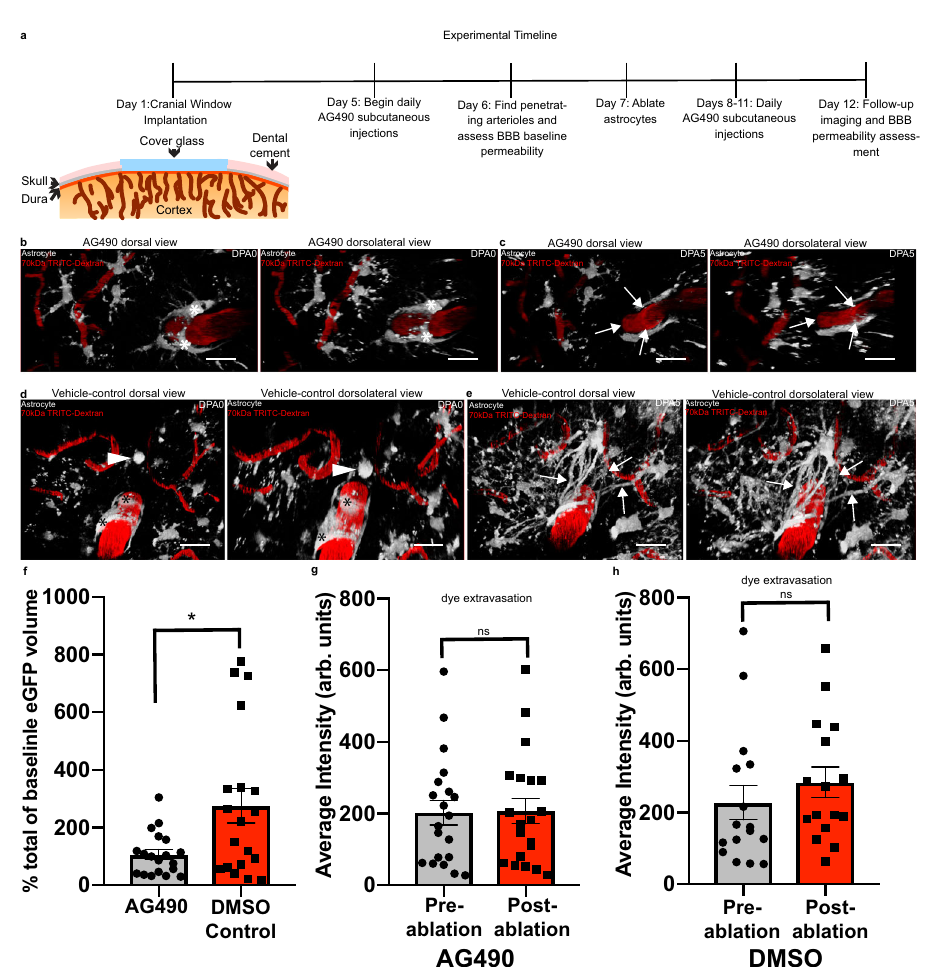
Fig. 5 The pharmacological inhibition of EGFR/pSTAT3 signi fi cantly reduces the volume of replacement astrocytes post-ablation. In order to determine if EGFR and pSTAT3 are necessary for gliovascular structural plasticity, we subcutaneously injected AG490. In all images, asterisks indicate ablated astrocyte(s) (shown in gray, blood vessels are in red), arrow heads indicate the eventual replacement astrocyte, and arrows demarcate replacement processes, or lack thereof. a Schematic illustrating the experimental timeline. Volumetric reconstructions showing the dorsal view (left) and dorsolateral view (right) of astrocytes and their interactions with a penetrating arteriole in AG490-injected mice at b dpa0 and c dpa5. Scale bar = 20 µ m. Volumetric reconstructions showing the dorsal view (left) and dorsolateral view (right) of astrocytes interacting with a penetrating arteriole in DMSO vehicle-injected control mice at d dpa0 and e dpa5. Scale bar = 20 µ m. n = 19 fi elds of view over 4 mice. f Bar graph comparing percent increase in eGFP volume at dpa5 relative to baseline in AG490-injected mice relative to DMSO-injected control, n = 19 penetrating arterioles over 4 mice, Two-tailed Mann – Whitney test, p = 0.0497. g Bar graph comparing the average intensity of 3 kDa TRITC extravasation in AG490 injected mice pre-ablation versus post-ablation, n = 20 penetrating arterioles over 4 mice, Two-tailed Wilcoxin matched pairs signed-rank test, p = 0.6215. h DMSO vehicle-injected control group, n = 16 penetrating arteriole over 4 mice, Two-tailed Wilcoxin matched pairs signed-rank test, p = 0.1167. Data are presented as mean values ± SEM. LUTS have been adjusted to emphasize the replacement astrocytes and associated